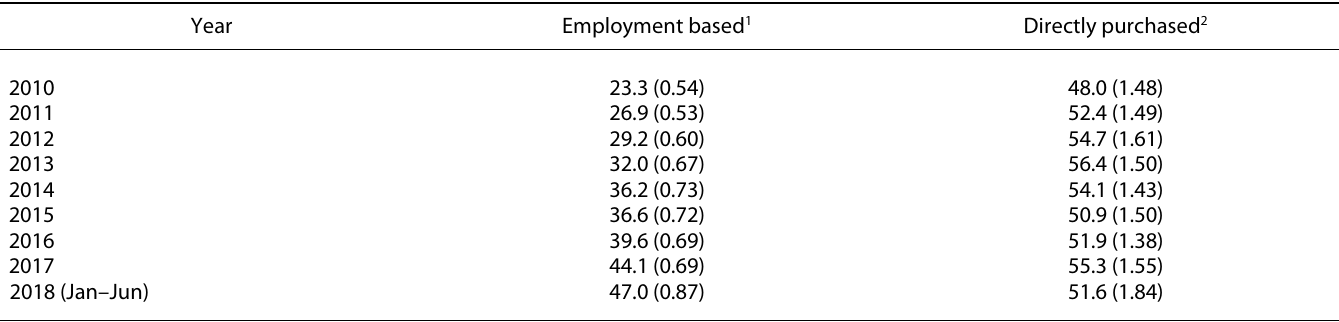
Table XII. Percentages (and standard errors) of persons under age 65 with private health insurance coverage who were enrolled in a high-deductible health plan, by year and source of coverage: United States, 2010–June